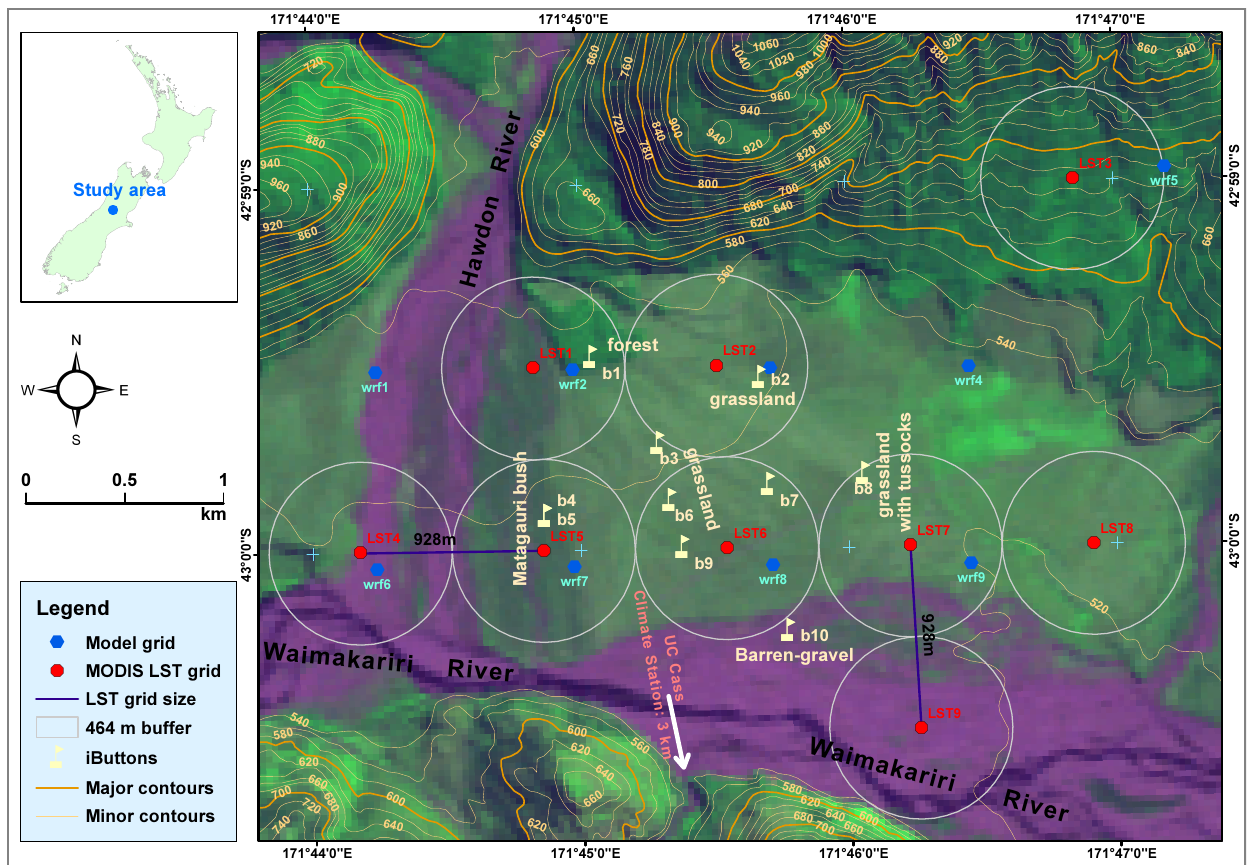
Figure 1. In situ iButtons (b1 to b10), MODIS grid points (LST1 to LST9) and the WRF model grid points (wrf1 to wrf9) overlaid on a Landsat image (TM5, 28 March 2011) of the test-site and plotted with 20 m topography contours